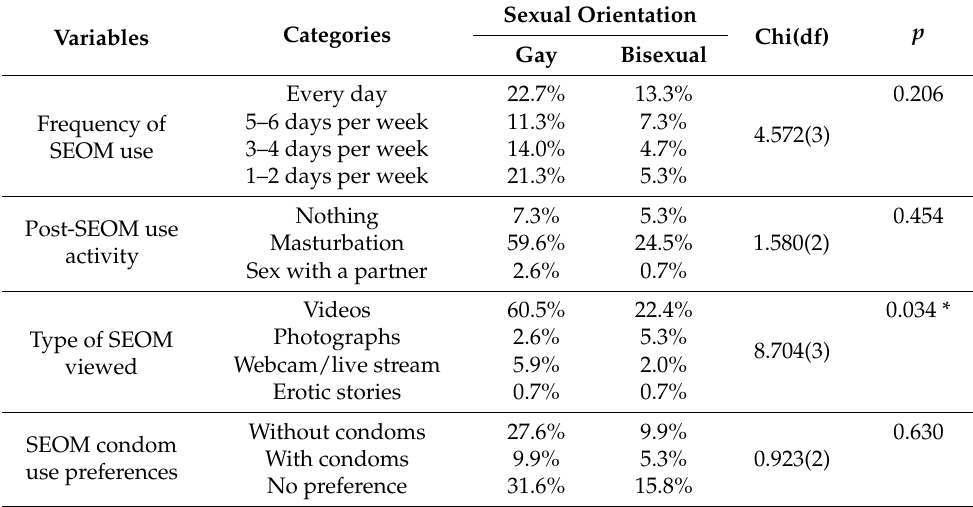
Table 4. SEOM Consumption by Sexual Orientation.